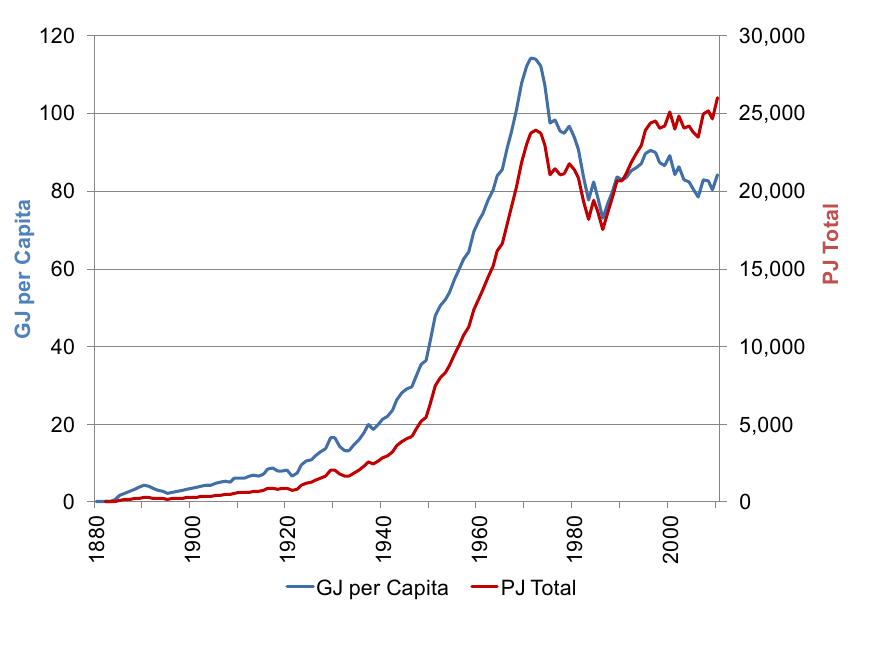
Figure 10. U.S. natural gas consumption, 1880–2010. Sources: [1] for 1880–1948; [25] for 1949–2010.